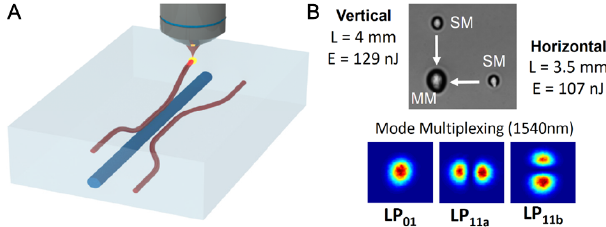
Figure 10: (A) 3D sketch of a mode-selective directional coupler for multiplexing of the LP 01 and LP 11 mode. The few-moded waveg- uide is shown in blue and the single-mode waveguides in red. The orthogonal alignment of the single-mode waveguides enables the selective multiplexing and demultiplexing of the LP 11a and LP 11b mode. (B) Microscope image of the chip’s end-face as well as near-field profiles of the few-moded waveguide. With permission from [160]. Copyright 2014 The Optical